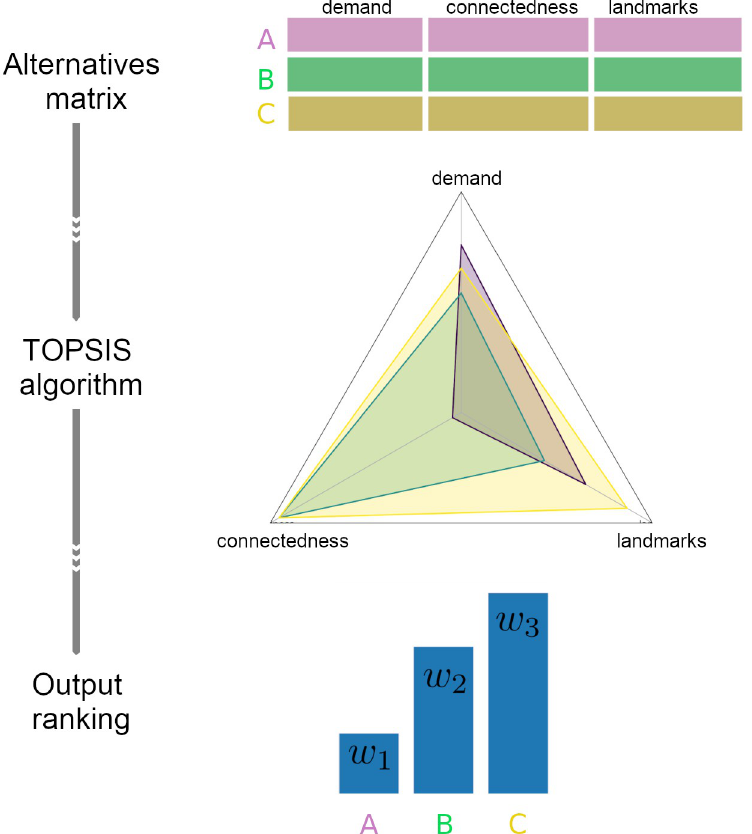
Fig 3. A visual schematic of the weight estimation procedure with the TOPSIS algorithm. First, the alternatives matrix is constructed and supplied to the TOPSIS algorithm. TOPSIS embeds the attributes into the Euclidean space. The three facility attributes are mapped on three axes: demand, connectedness and landmarks. From the radar plot, it is clear that facility C has overall better characteristics. Hence, it gets a higher ranking. The output is the facility weights.